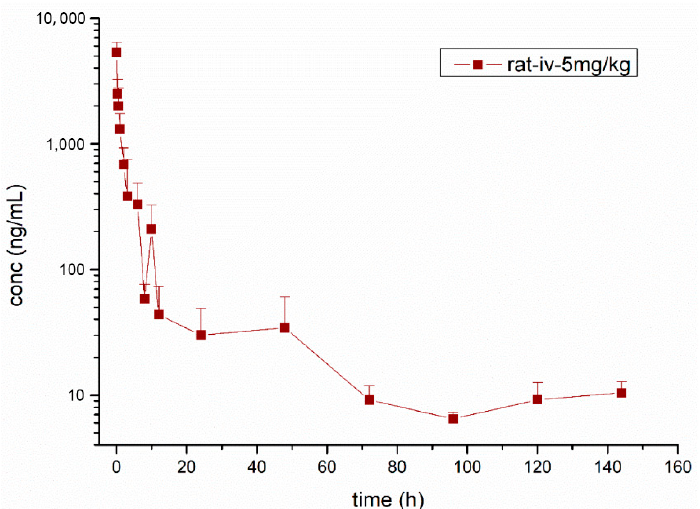
Figure 4. Mean plasma concentration-time profile of lekethromycin in rats after intravenous administration of lekethromycin at a single dose of 5 mg/kg.